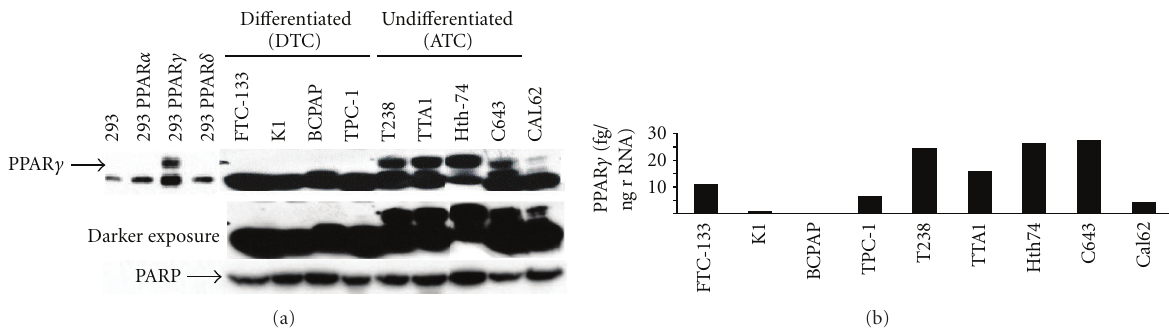
Figure 2: Protein and mRNA levels of PPAR γ in thyroid cancer cells. (a) 60 μ g of nuclear extract protein from various papillary and anaplastic thyroid cancer cells and 293 cells overexpressing PPAR α , γ , or δ was separated on a 10% SDS-PAGE gel and transferred to a PVD membrane.The blot was blocked with 10% nonfat milk and incubated overnight with PPAR γ rabbit polyclonal ab (sc-7196, Santa Cruz, CA) at a dilution of 1:500. Secondary antibodies were anti-rabbit IgG conjugated to horseradish peroxidase (GE Healthcare UK) at a 1:1000 dilution. PARP was quantitated as a loading control. (b) 200 ng of total RNA from the same thyroid cancer cells was subjected to qRT-PCR using an ABI PRISM7700 and the PPAR γ -specific oligos and probe described in Section 2.5. PPAR γ mRNA levels are shown per ng of 18 s rRNA.